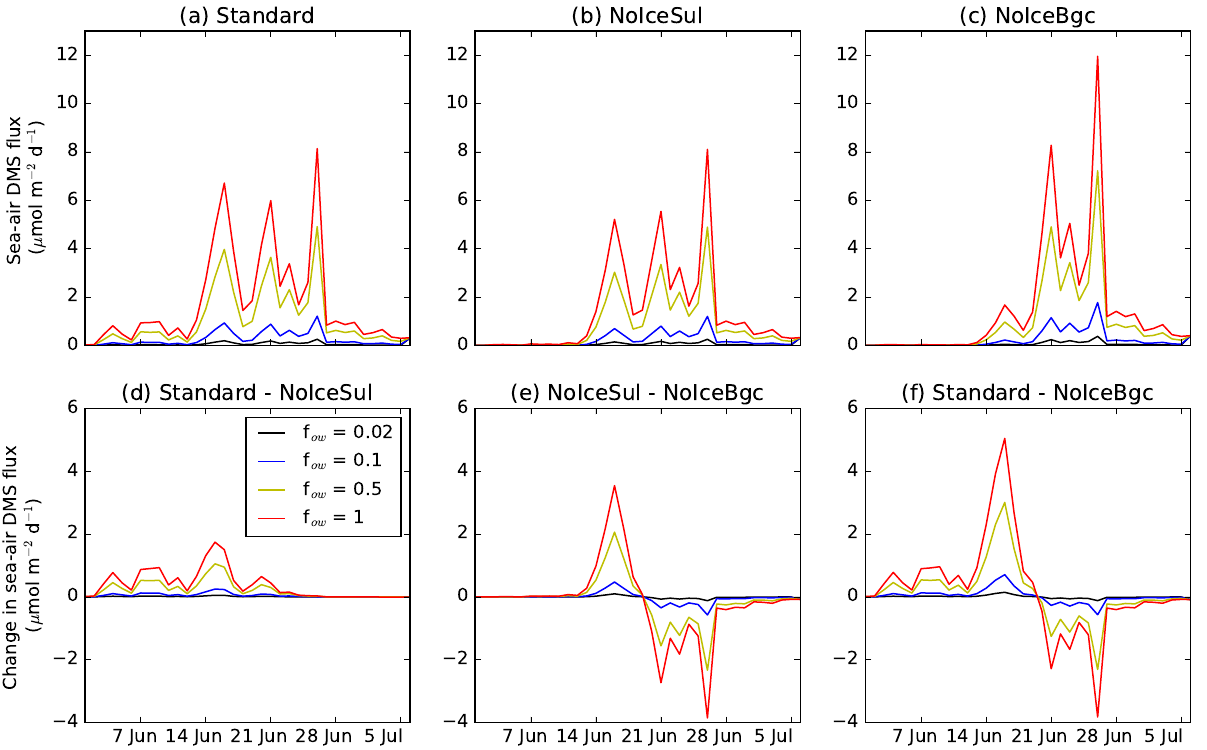
Figure 9. Simulated time series of sea–air DMS fluxes (µmolm − 2 d − 1 ) with four different open-water fraction values ( f ow ) for (a) the standard run and the sensitivity runs that excluded (b) the sea-ice sulfur cycle (NoIceSul) and (c) both the sea-ice sulfur cycle and ecosystem (NoIceBgc) and the flux difference between (d) the standard and NoIceSul runs, (e) the NoIceSul and NoIceBgc runs, and (f) the standard and NoIceBgc runs during the melt period in 2010. In panels (d) , (e) , and (f) , positive values represent enhancement in the simulated flux due to the incorporation of sea-ice sulfur cycle, ecosystem, and both sulfur cycle and ecosystem, respectively, while negative values represent